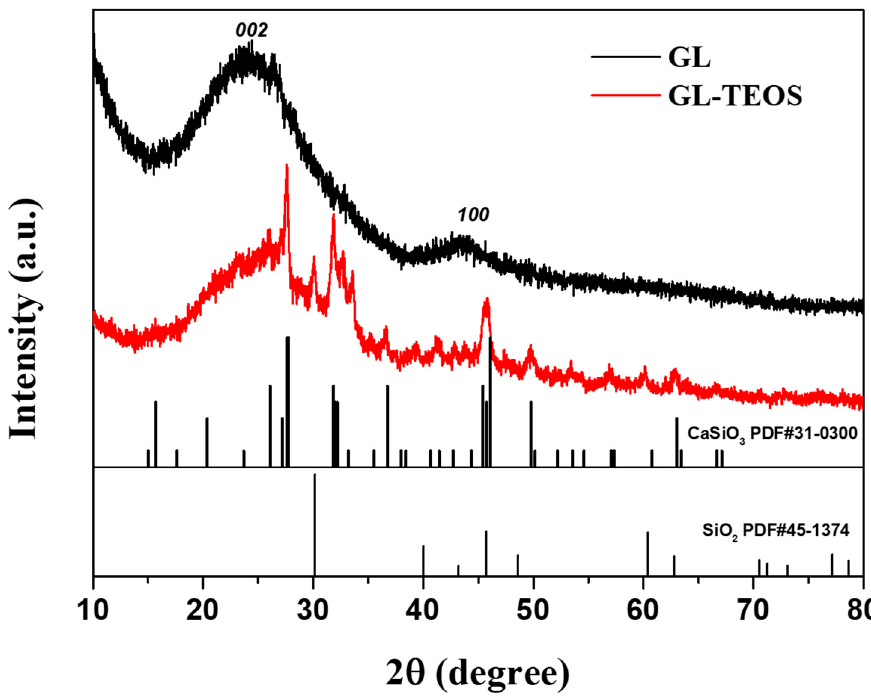
Figure 4. XRD patterns of GL and Figure 4. XRD pa tt erns of GL and GL-TEOS.